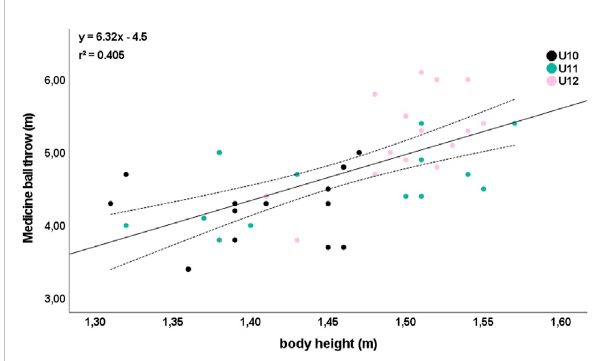
Relationship between body height and agility T-half test. Please note that one dot can represent several subjects.